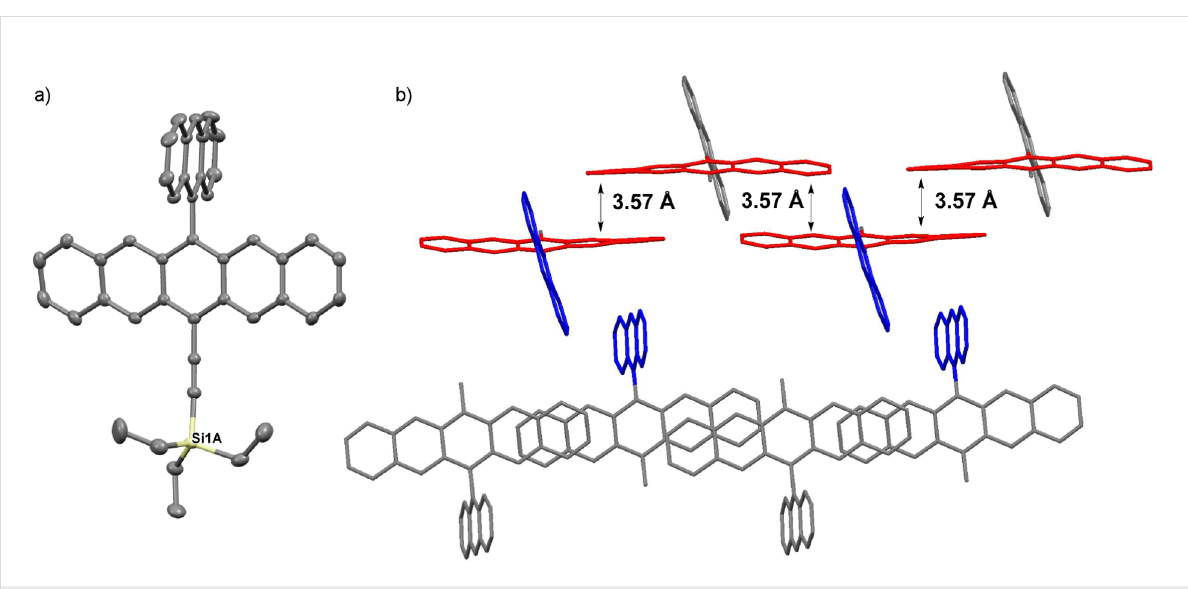
Figure 10: X-ray crystallographic analysis of 3h showing a) molecular structure and b) packing motif (triethylsilyl groups omitted for clarity); ORTEP drawn at 50% probability level.